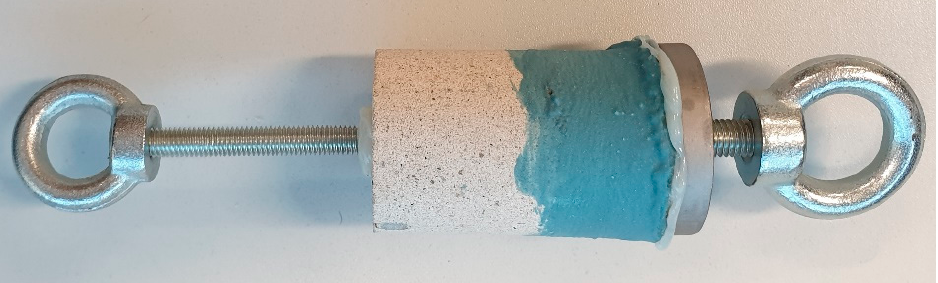
Figure 9. Detail of a test specimen with a glued target.